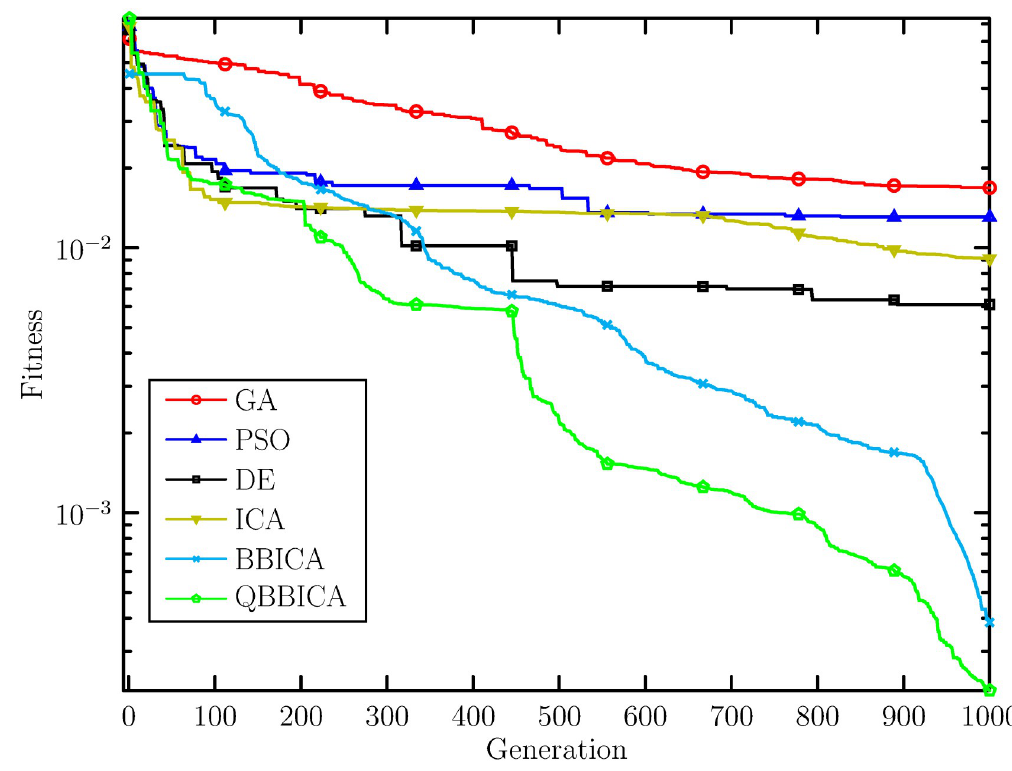
Fig 6. Fitness evolution curve of QBBICA, BBICA, ICA, PSO, GA and DE.